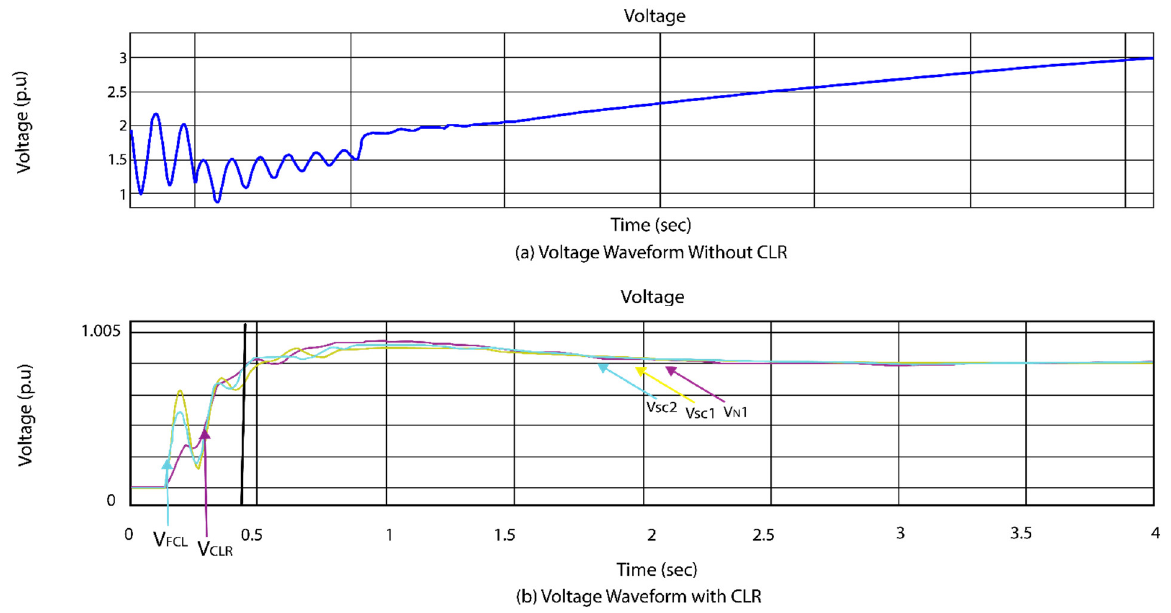
Figure 9. Voltage waveforms due to the CLR’s resistance (pu).